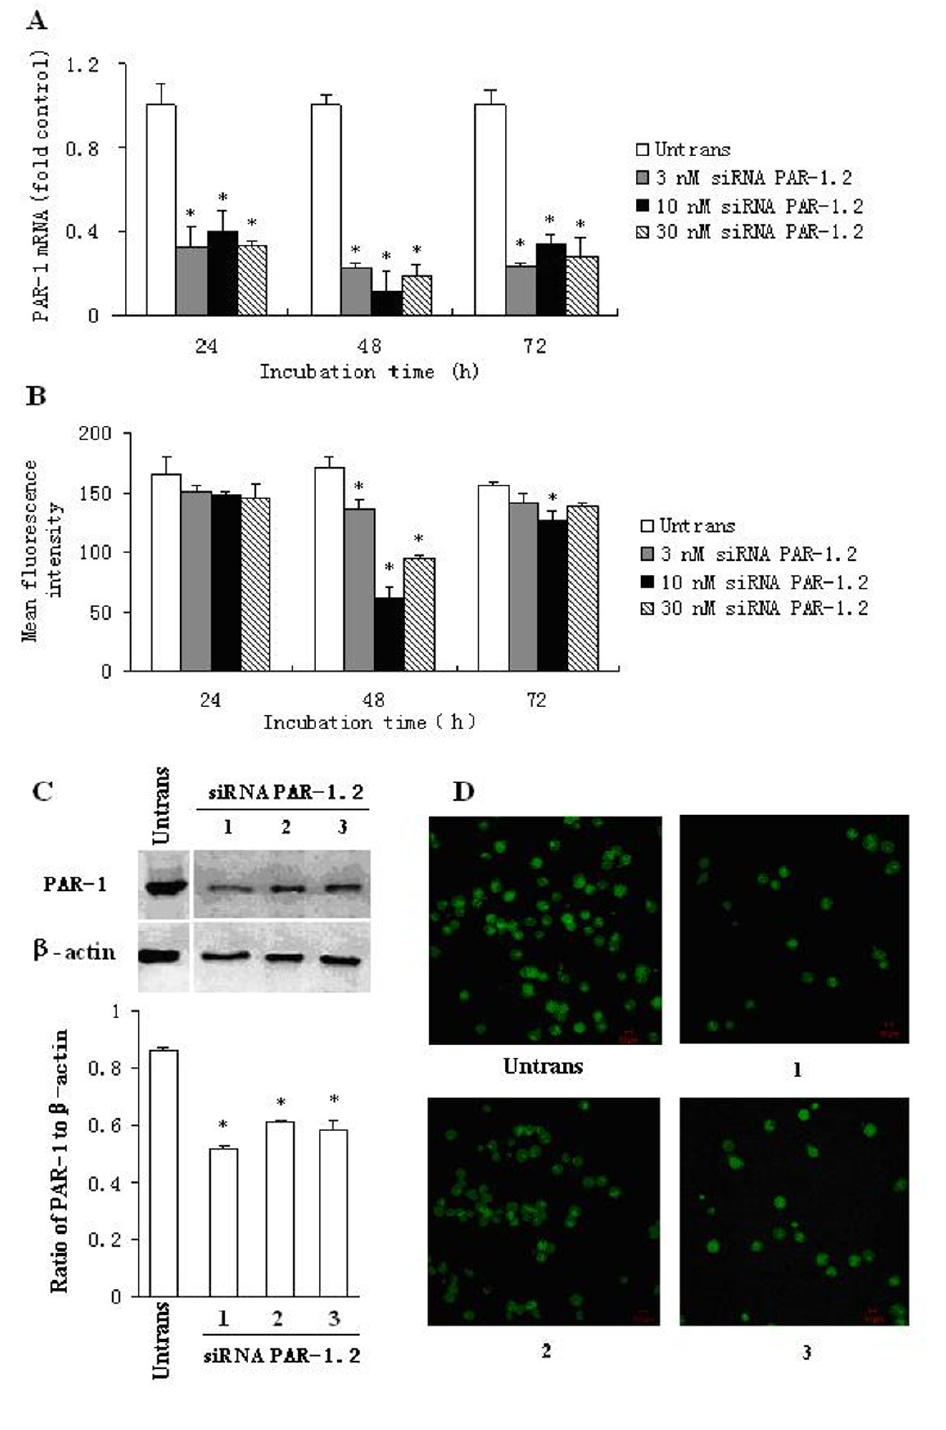
Figure 1 Effect of siRNA PAR-1.2 on PAR-1 expression in P815 cells . P815 cells were transfected with siRNA PAR-1.2 for 24, 48 and 72 h. The PAR-1 expression was determined by real-time quantitative PCR (A), flow cytometry (B), Western blot (C) and immunofluorescent analysis (D). In (C) and (D), 1 = 3 nM, 2 = 10 nM and 3 = 30 nM of siRNA PAR-1.2. Values shown are mean ± SEM for four to five independent experiments. * P < 0.05 compared with the untransfected